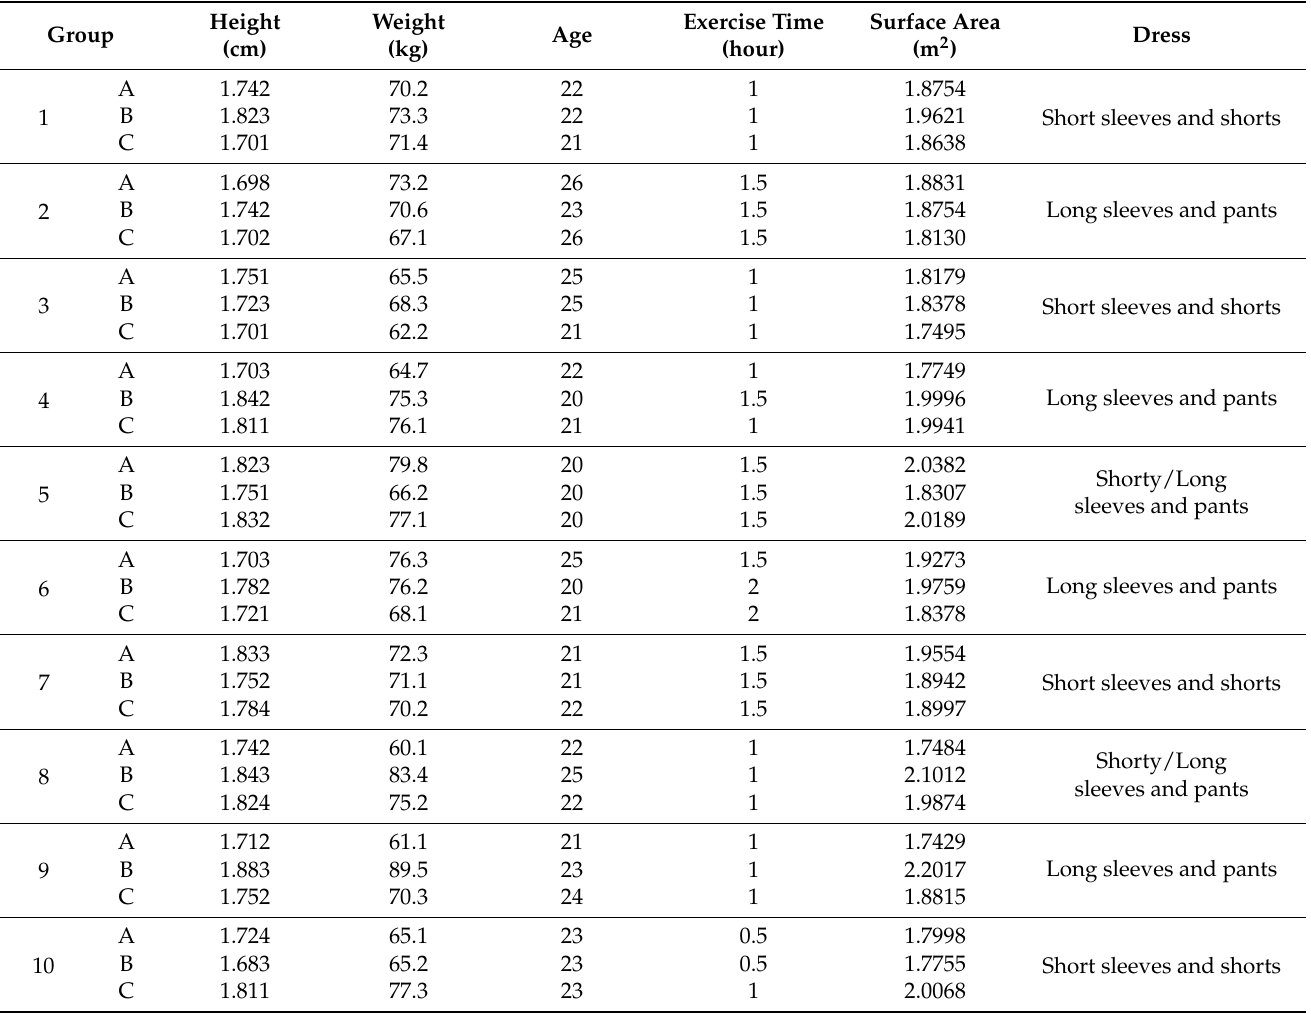
Table 5. Basic information of the subjects.